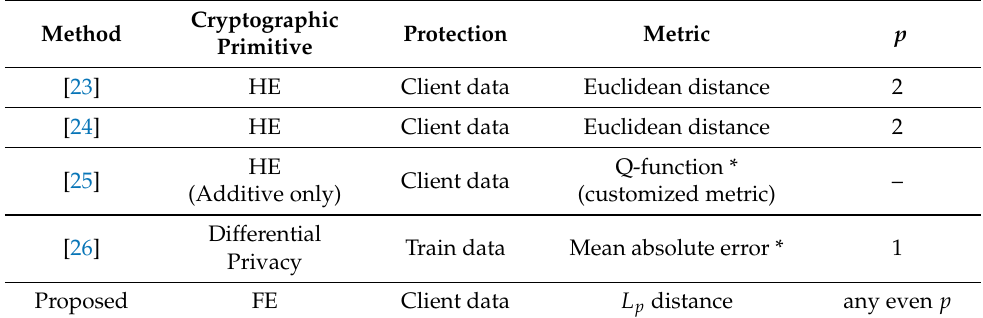
Figure 2. Execution time (ms) of EncodeX and EncodeY on Raspberry Pi. Table 2. Comparison of privacy-preserving anomaly detection methods (* computed in